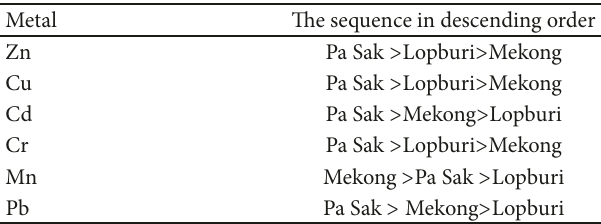
Table 2: Heavy metals concentration of C. fluminea in descending order from three